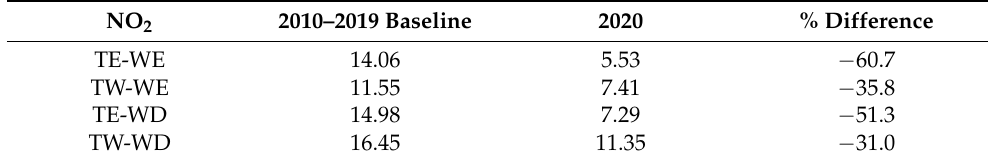
Table 2. The 3-month (April to June) aggregate results for NO 2 for the baseline period (2010–2019) and 2020 and the percentage reduction for 2020 from the baseline period, analyzed for Toronto East (TE) and Toronto West (TW) for both weekends (WE) and weekdays (WD).